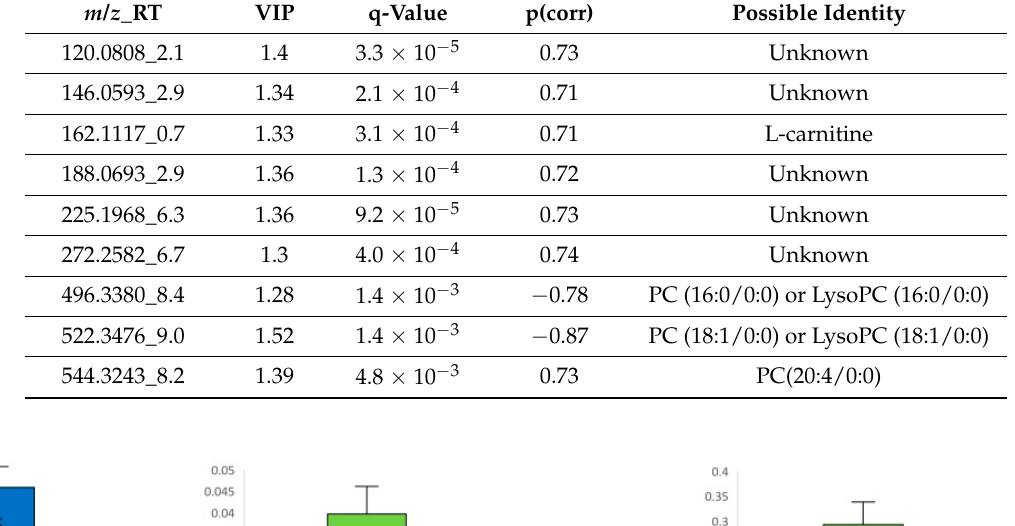
Figure 3. Orthogonal partial least squares discriminant analysis (OPLS-DA) score plots of the con- trol and necrotizing enterocolitis (NEC) groups. Y and X axes represent [t2] and [t1], respectively.